Question: Briefly state, in one sentence, what is plotted here.
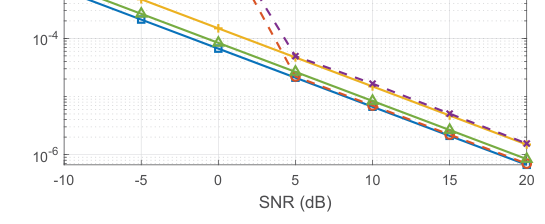
Answer: MSE versus SNR in the case of 1D array.